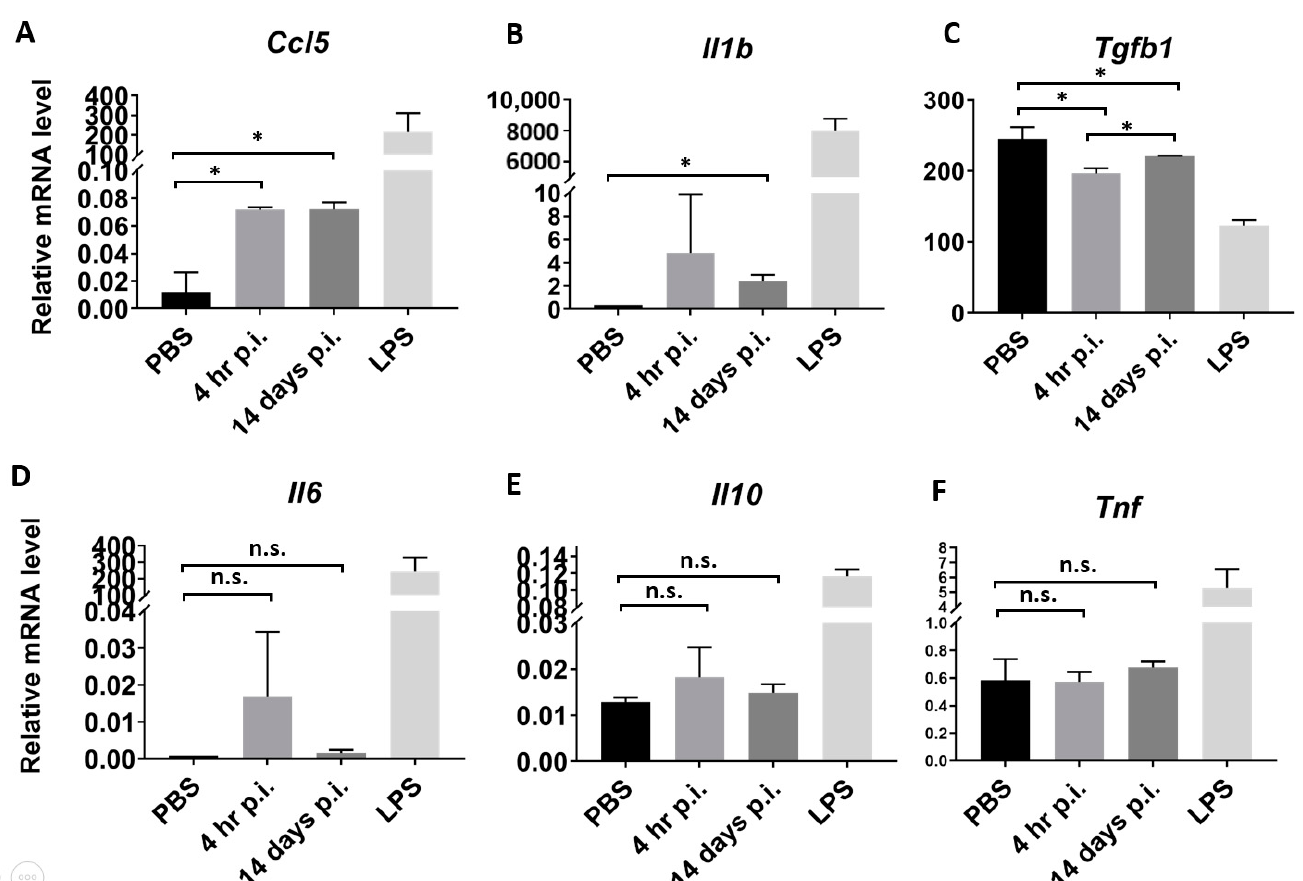
Figure 5. Serum exosomes from O. tsutsugamushi -infected mice modulate cytokine expression in macrophages. BMDMs were treated with PBS (vehicle control), serum exosomes from infected mice or LPS (5 µg/mL) for 24 h and mRNA transcript levels of cytokines or chemokines ( A , Ccl5 ; B , Il1b ; C , Tgfb1 ; D , Il6 ; E , Il10 and F , Tnf ) were determined and normalized to the expression of Gapdh as endogenous control (n.s., not significant; * p -value ≤ 0.05). The experiment was repeated twice and representative data were shown. Error bar, standard deviation.